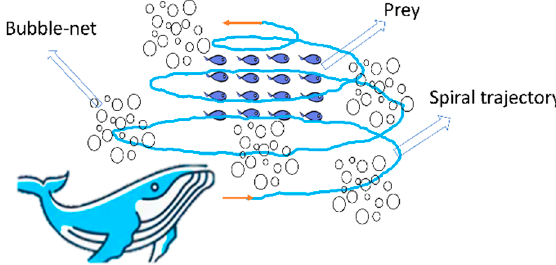
Figure 3. Bubble-net attacking method of whales.